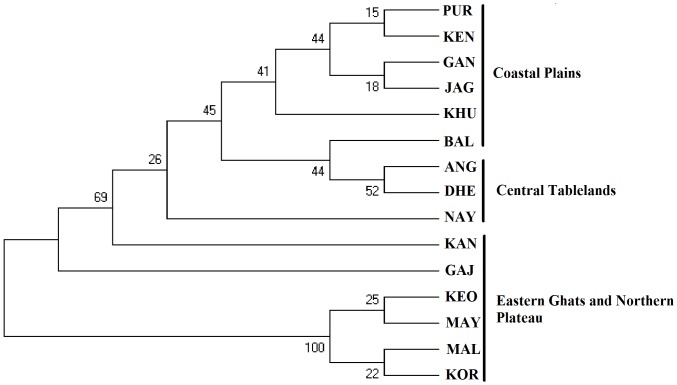
Dendrogram based on chord distance clustering by NJ method using Mega 5.01.The genetic relationship among 15 Ae. albopictus populations sampled in Orissa is shown.